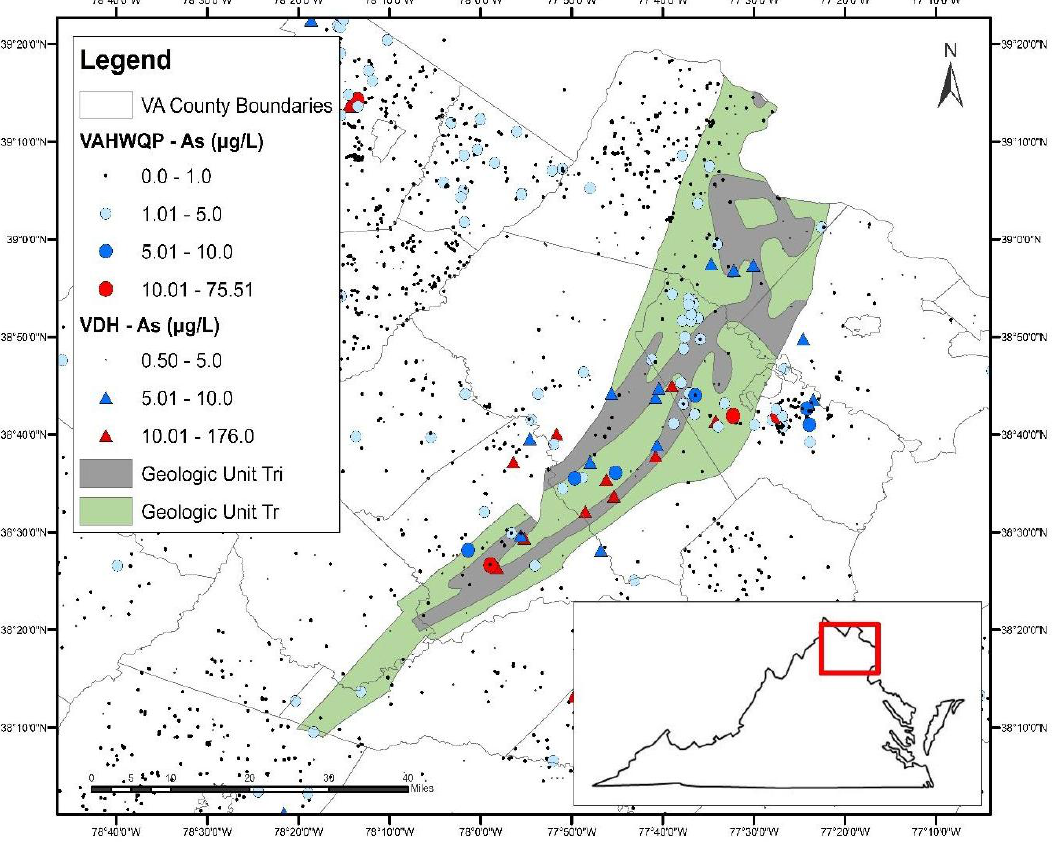
Figure 4. The Culpeper Basin located in north-central Virginia (inset) with overlays of Triassic-aged sedimentary rocks (green), the Triassic-Jurassic intrusives (grey) and As concentrations in well water.